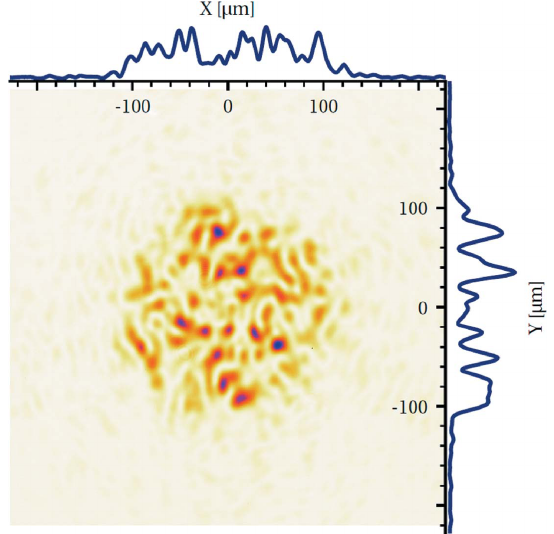
Figure 9 Capture of the laser spot at the sample position using a hybrid phase plate designed to generate a 250 m m focal spot. The profiles shown at the top and to the right are 40 m m thick lineouts through the focal spot at Y = 0 and X = 0, respectively. Full width at half-maximum (FWHM) is close to 200 m m along both axes. Enclosed energy measurements on this figure show 50% of the energy inside a 180 m m diameter, 70% inside a 226 m m diameter and 80% inside a 290 m m